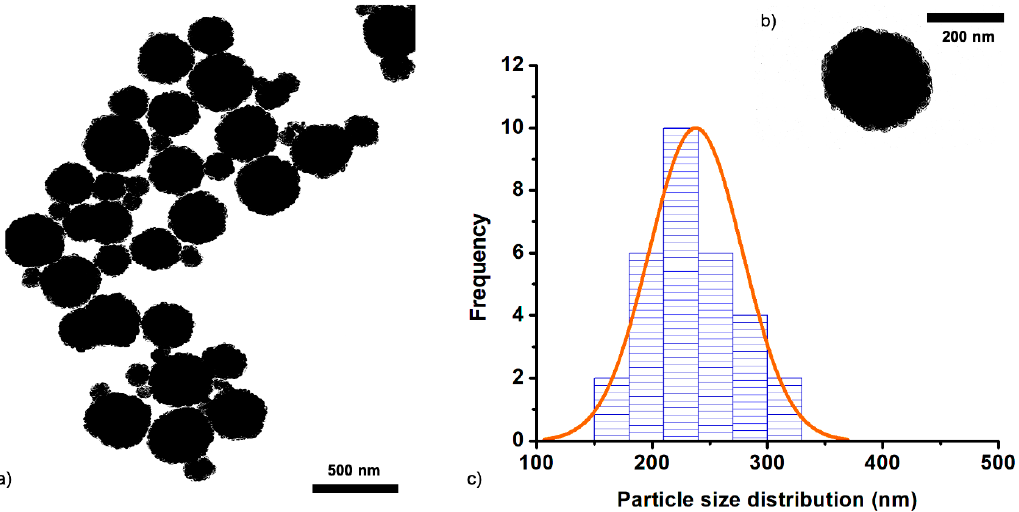
Figure 2. TEM micrographs ( a , b ) of MNPs prepared by solvothermal method using double surfactant (spMNPs) along with particle size distribution ( c ) determined with imageJ2 software.